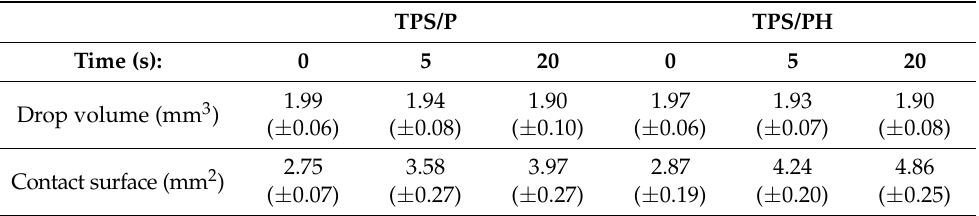
Table 2. Drop volume and surface of contact of the drop with TPS/P and TPS/PH films as a function of time (0–20 s). Values are mean ±